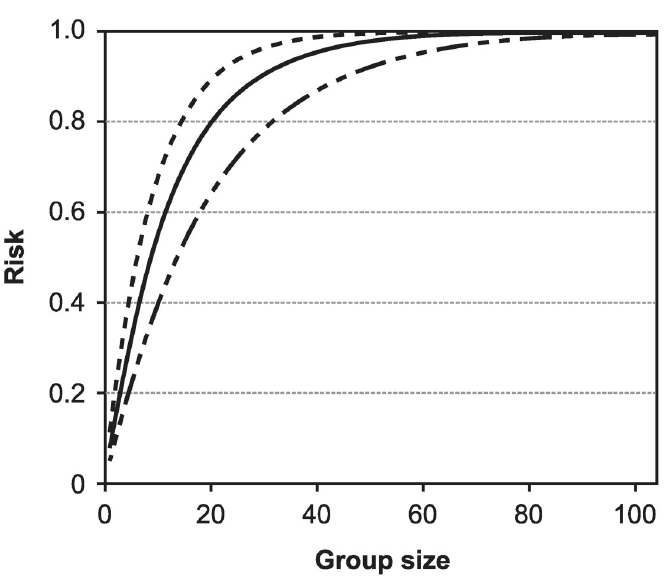
Fig 11. The risk of including asymptomatic individuals in groups of different sizes. The solid line corresponds to using the MLEs for ^ f ; ^ g , and ^ r in the risk formula (Eq 44), and the two dotted lines correspond to using the minimum and maximum values of ρf on the 95% CR contour.